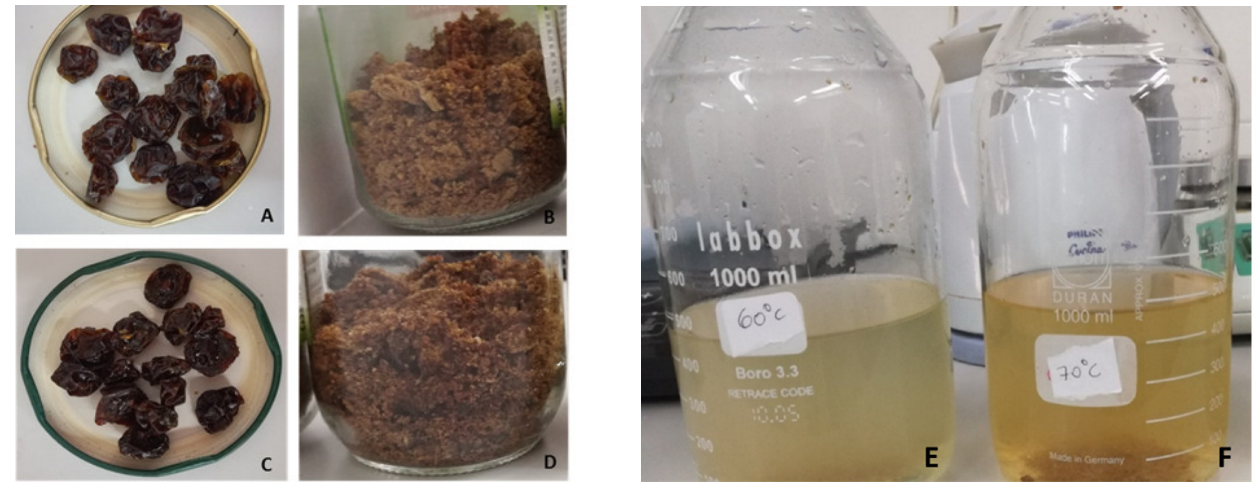
Figure 8. Dehydrated berries at 60 °C ( A ) and crushed ( B ); Dehydrated berries at 70 °C ( C ) and crushed ( D ); Lyophilized berries ( E ). The appearance of infusions prepared from dried berries at 60 °C ( E ) and 70 °C ( F ).